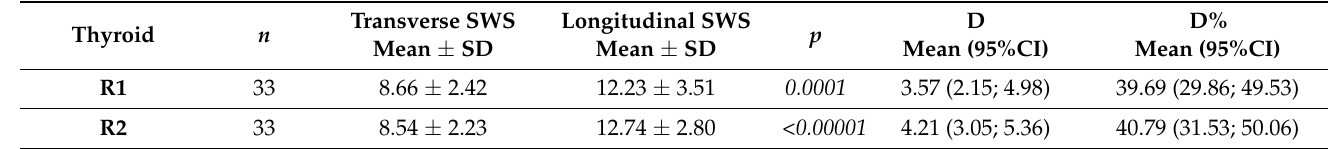
Table 3. Comparison of the thyroid SWS values measured in the transverse and longitudinal planes.